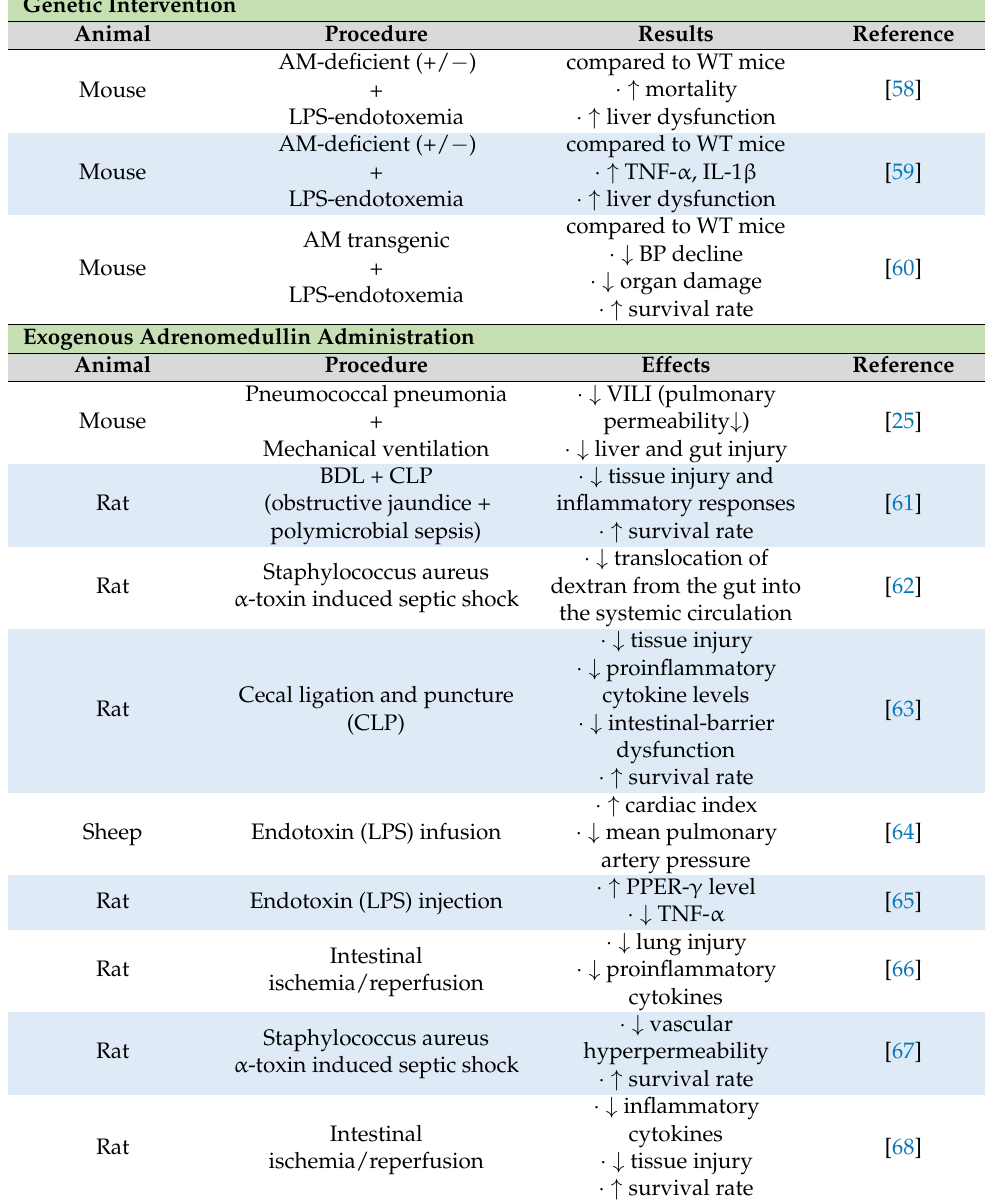
Table 1. The effects of adrenomedullin on septic